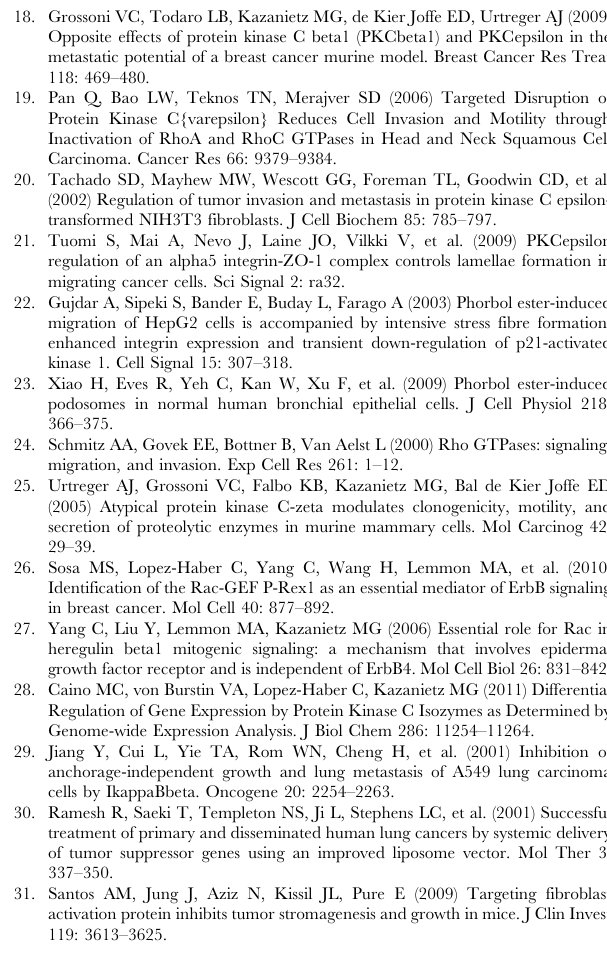
Figure S8 Detection of ECM-proteases secreted to conditioned media (CM) either from control or PKC e - depleted A549 cells. A549 cells transfected with either PKC e RNAi or control duplexes, and CM was collected as described in Experimental Procedures. A) ECM-proteases were detected in CM from control ( CTRL-CM ) or PKC e -depleted cells ( PKC e -CM ) using a protein array detection system from RayBiotech. IC , internal positive control. B) MMP9 activity was assayed by zymography. Two additional experiments gave similar results.